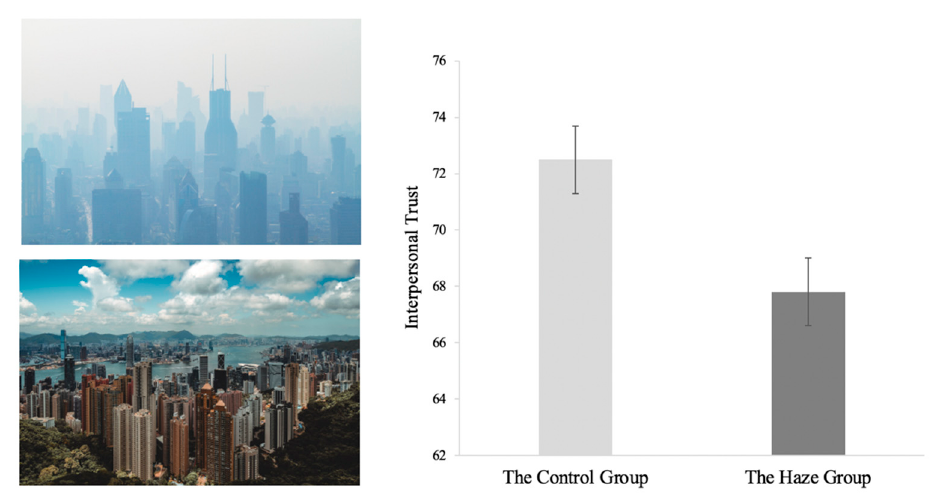
Figure 1. Hazy and clear scenes (left panel) and interpersonal trust scores by condition (right panel). Error bars represent 95% confidence intervals of the means. Haze reduced interpersonal trust. Public domain photos downloaded from https://unsplash.com for illustrative purpose (accessed on 24 May 2021).